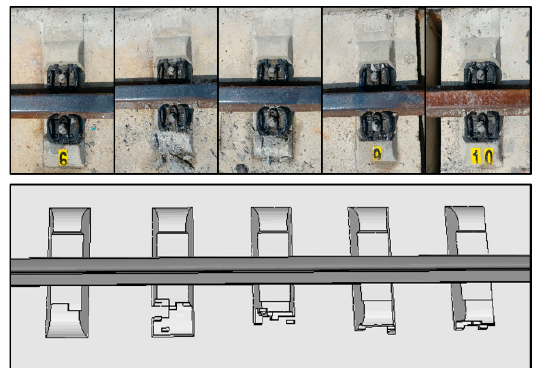
Figure 23. Comparison of location of broken sleepers.